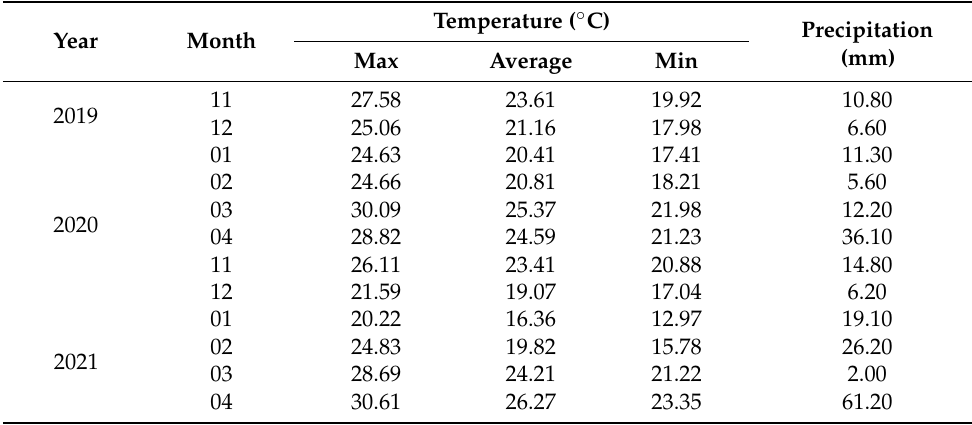
Table 1. Climate during the sweetpotato growing